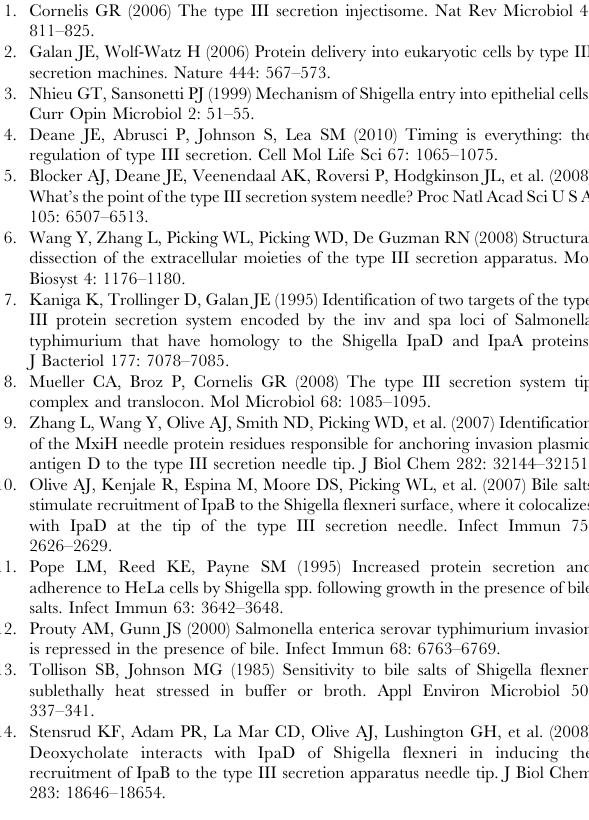
independent experiments. Figure S8 Hydrophobic surfaces stabilize the PrgI- SipD D D1 fusion protein. Two perspectives of SipD (green cartoon on the left, surface representation on the right) and PrgI (surface representation on the left, blue cartoon on the right). Surfaces are coloured according to the electrostatic potential, blue: positive, red: negative). Uncharged surface patches at the interface between the two proteins indicate hydrophobic contacts. Figure S9 Circular Dichroism spectra obtained at 20 6 C and 37 6 C from purified SipD and SipD mutants. Except for I142S the spectra obtained from six mutants described in Figure 4 show similar secondary structure content at 20 u C (upper panel) and at 37 u C (lower panel). Mutant I142S shows reduced folding stability compared to wildtype, particularly at 37 u C. Data at 37 u (lower panel) were recorded to a lower limit of 1980 A˚ to avoid spectra distortion due to high photomultiplier voltage obtained with a temperature controlled cuvette with 1 mm optical path length. Figure S10 Host invasion assay of PrgI mutant comple- mented S. typhimurium knockout cells. Figure S11 Superposition of the different copies found in the SipD crystal structure. Chain A (orange), chain B (light blue), chain C (red), and chain D (green) were superimposed and the region of the coiled-coil around Ser148 is highlighted. Chains